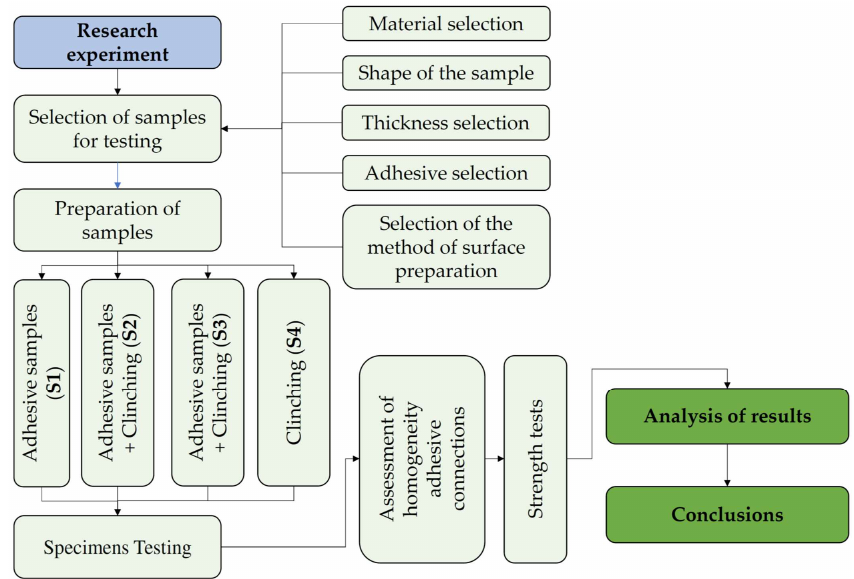
Figure 5. Plan of the research.